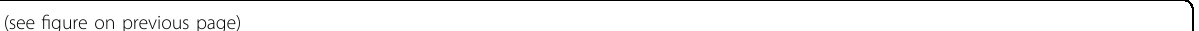
Fig. 2 Cartilage-speci fi c deletion of EP4 regenerates the stable mature articular cartilage by promoting cartilage chondrogenesis and anabolism. a – c Representative images of distal femur of Sham or MF-operation 8 weeks after surgery in EP4 f/f or Ep4 f/f ; Col2-Cre ( Ep4 Col2 ) mice ( a ). Yellow arrows show the defect region. International Cartilage Repair Society (ICRS) macroscopic evaluation score assessment was performed ( b ). The S.O. staining of the articular cartilage sections. Scale bar, 200 μ m. ICRS Visual Histological Score of regenerated tissues were performed ( c ). The articular cartilage sections from sham or MF surgery were stained with indicated antibodies ( a ). Nuclei are shown by DAPI staining. Scale bars, 200 μ m. Dotted lines indicated the surface of articular cartilage and dotted boxes indicated the defect region. n = 5 for each group. Error bars are means ± s.d., ** P < 0.01 by student t -test. ns, not signi fi cant; IF, immuno fl uorescence. d , e The pain was measured by Von Frey assay ( d ) and radiant heat paw-withdrawal test ( e ). Error bars are means ± s.d., n ≥ 5 for each group, ** P < 0.01, *** P < 0.001, **** P < 0.0001 by one-way ANOVA with multiple comparison using Tukey method. f Quanti fi cation for the modulus of the regenerate 8 weeks after MF surgery. n = 5 for each group, error bars are means ± s.d., ** P < 0.01, **** P < 0.0001 by one-way ANOVA with multiple comparison using Tukey method. g – j Representative images of S.O. staining of Sham-operation or DMM at 8 weeks after surgery in EP4 f/f or Ep4 f/f ; Aggrecan-CreERT2 ( Ep4 AcanERT2 ) mice. Scale bar (top), 500 μ m; scale bar (bottom), 200 μ m. The corresponding OARSI scores were performed ( h ). Error bars are means ± s.d., n = 5 for each group, ** P < 0.01, *** P < 0.001, **** P < 0.0001 by ordinary one-way ANOVA with multiple comparison using Tukey method. ns not signi fi cant. Knee joint sections were stained with antibodies against Col2a1 (Scale bars are 100 μ m) and Sox9 (Scale bars are 50 μ m) ( g ). Nucleus were shown by DAPI staining. Dotted lines indicated the surface of articular cartilage. The Col2a1 and Sox9 expression were quanti fi ed in i and j , respectively. Error bars are means ± s.d., n = 3 for each group, * P < 0.05, ** P < 0.01, *** P < 0.001, **** P < 0.0001 by ordinary one-way ANOVA with multiple comparison using Tukey